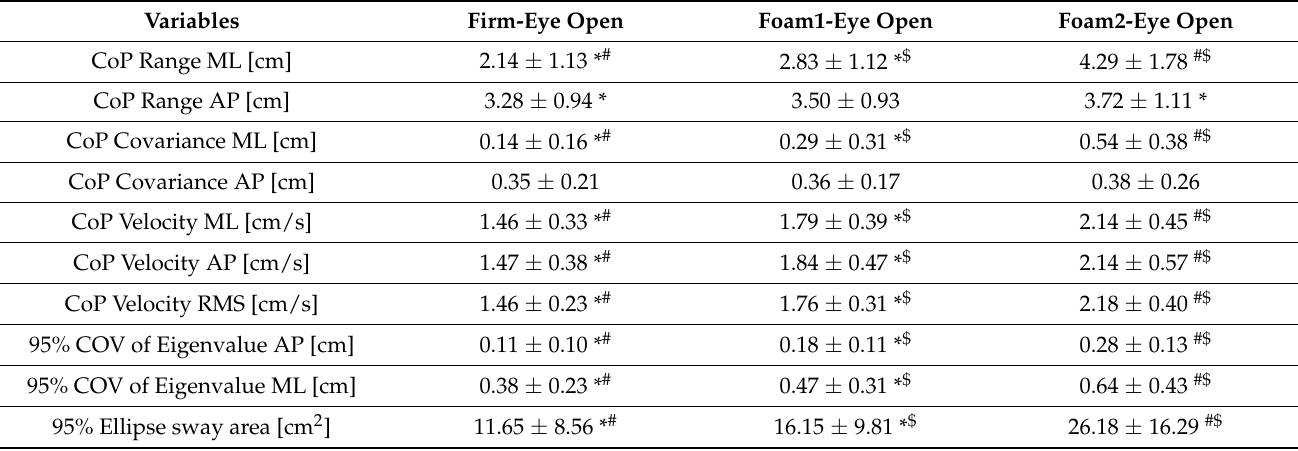
Table 2. Difference between the surfaces with normal visual condition.